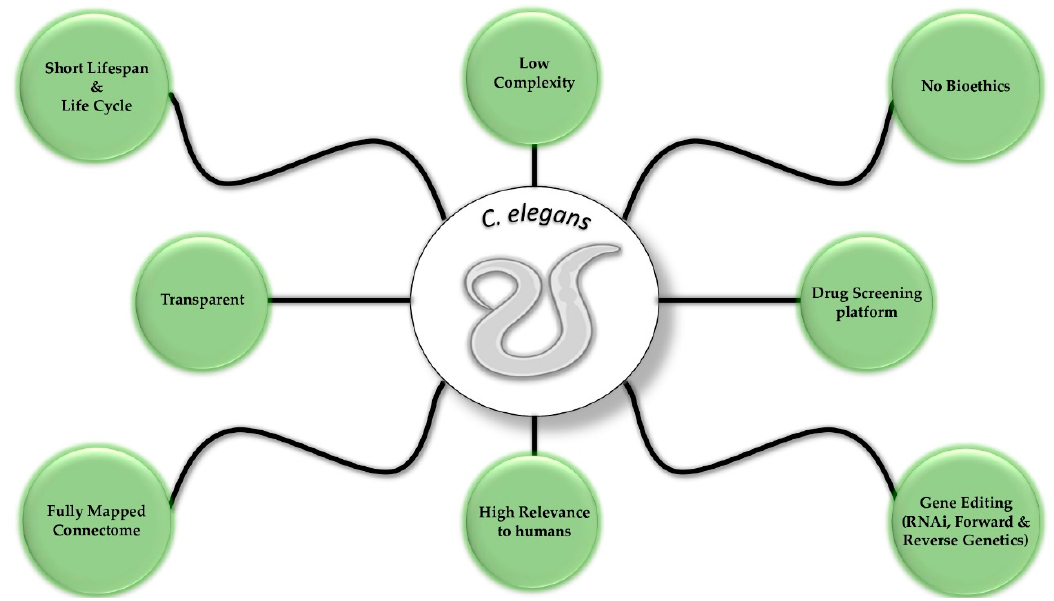
Figure 2. Selected advantages of C. elegans that render it an ideal animal model.